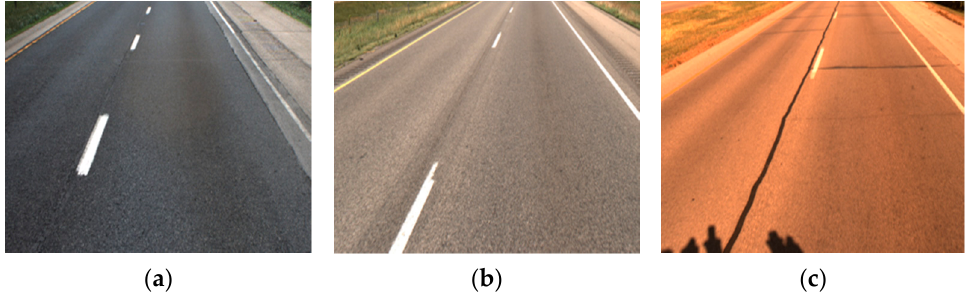
Figure 4. RGB images for two-lane highways in the source domain datasets: ( a ) dataset 1, ( b ) dataset 2, and ( c ) dataset 3.